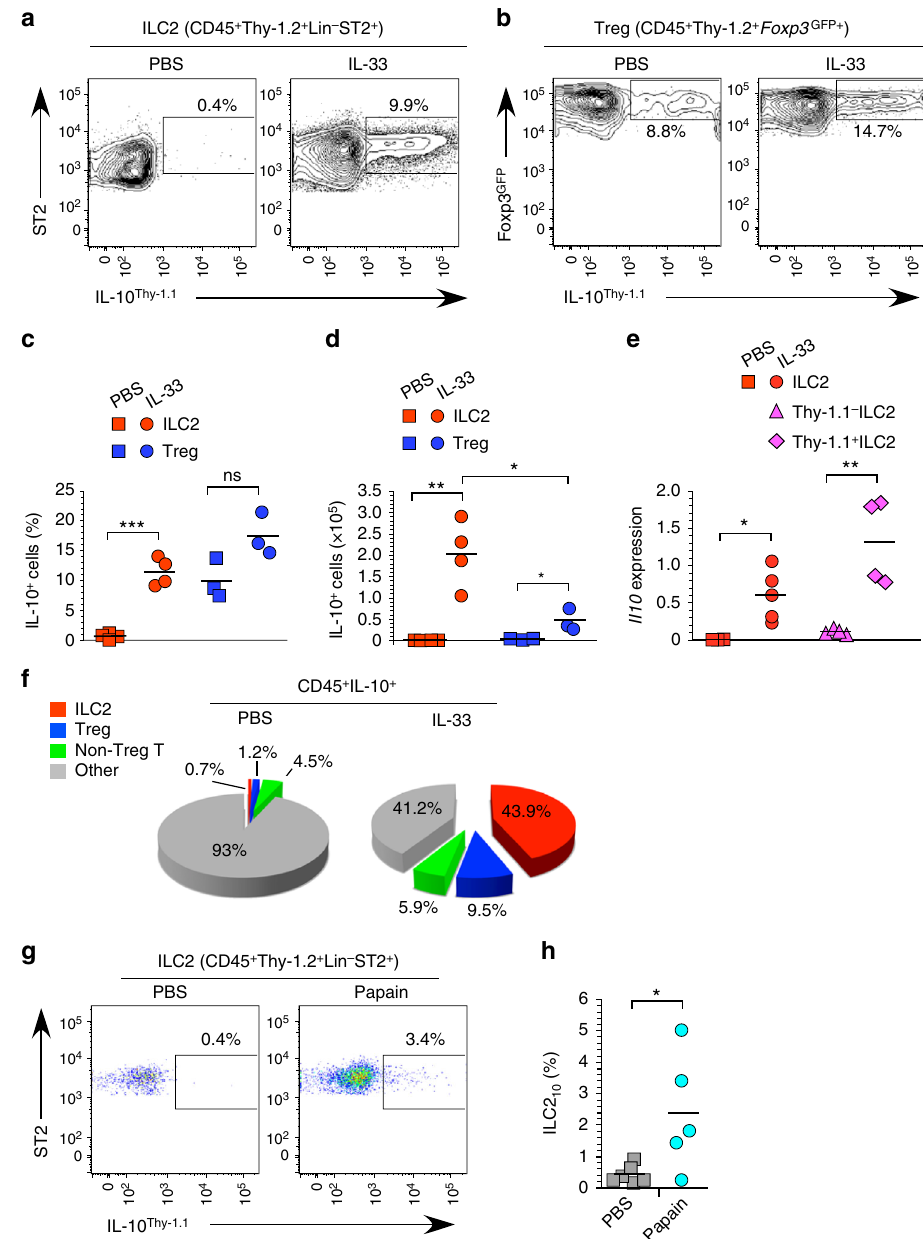
Fig. 2 ILC2 10 constitute a major subset of IL-10 producing lung hematopoietic cells. a , b Flow cytometry analysis of ILC2 ( a ) or T reg cells ( b ) from the lungs of 10BiT Foxp3 GFP dual reporter mice treated with PBS (left) or IL-33 (right). c , d Quantitation of the frequency ( c ) and number ( d ) of lung ILC2 10 and T reg cells, calculated from gates as in a and b, here and in all subsequent fi gures. e Il10 gene expression from total ILC2 from wild-type mice (red) or subsets of ILC2 from 10BiT Foxp3 GFP mice (pink) treated with PBS or IL-33. f Frequency of cell types including ILC2 as in a , T reg cells as in b , non-T reg T cells (Lin +